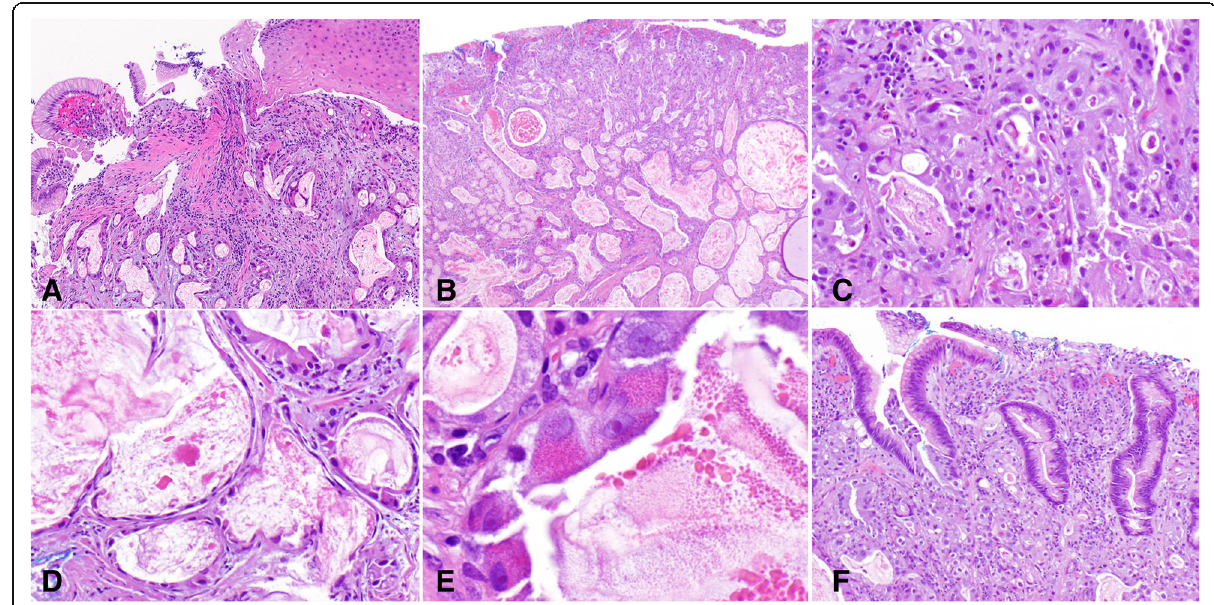
Fig. 2 Histopathology. a Biopsy (10x). b - f endoscopic resection: b Low power view (4x) showing poorly-differentiated area on the upper half and well-differentiated cystic area on the lower half. c Poorly-differentiated area (20x): tumor cells formed small glands and solid growth. d Well- differentiated area (20x): bland-appearing cystically dilated glands contained granular eosinophilic luminal secretion. e Cytomorphology of the tumor cells (60x): cytoplasm of tumor cells contained eosinophilic coarse granules. f Overlying squamous-columnar junction mucosa with reactive changes. No intestinal metaplasia was identified